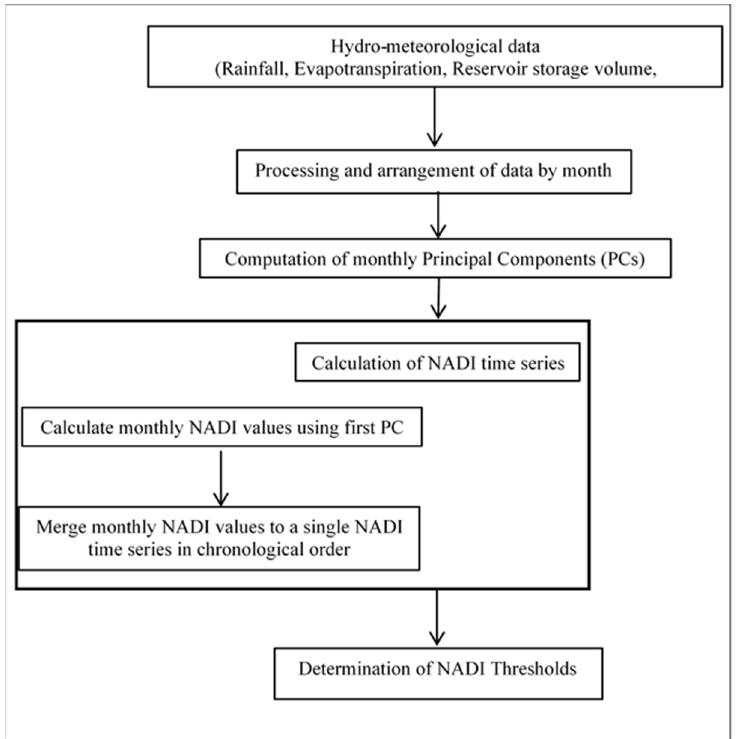
Figure 2. Formulation of the Non-linear Aggregated Drought Index flowchart (Source; [20]).